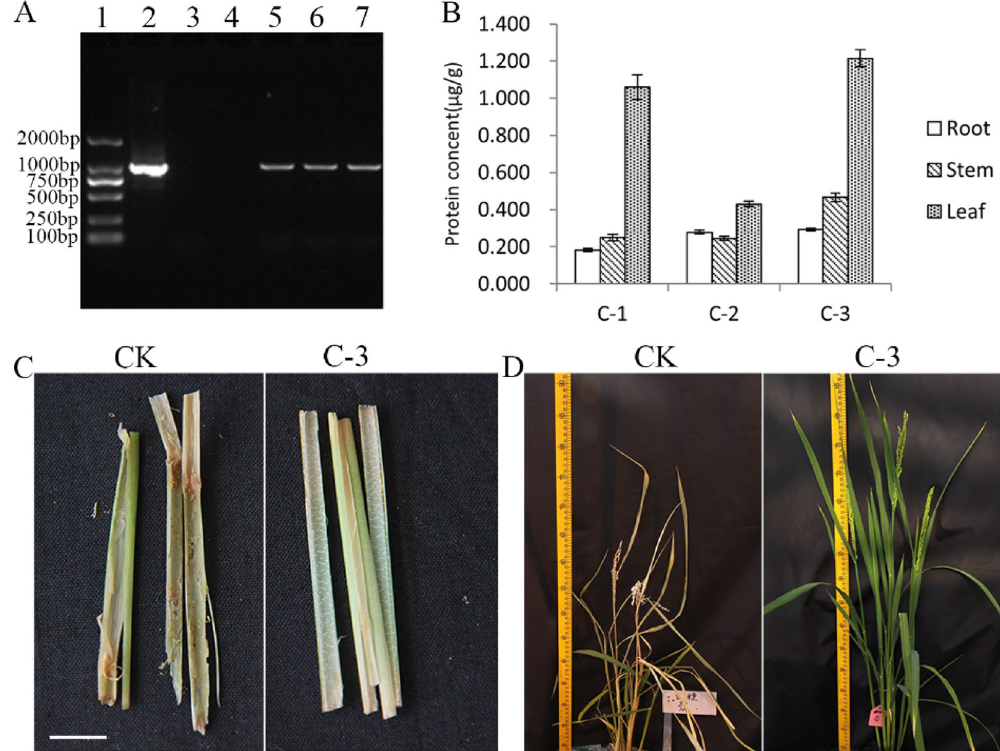
Figure 2. Expression and insect resistance analysis of Cry1Ab-Gc protein in rice. ( A ) PCR analysis of rice genomic DNA. 1: DL 2000 Marker; 2: Plasmid positive control; 3: Black control; 4: Negative Control; 5: Transgenic event C-1; 6: Transgenic event C-2; 7: Transgenic event C-3. ( B ) ELISA of Cry1Ab-Gc protein in three transgenic events. ( C ) Insect resistance performance of rice stems in the laboratory. Scale bar, 1 cm. ( D ) Insect resistance performance in the glasshouse.